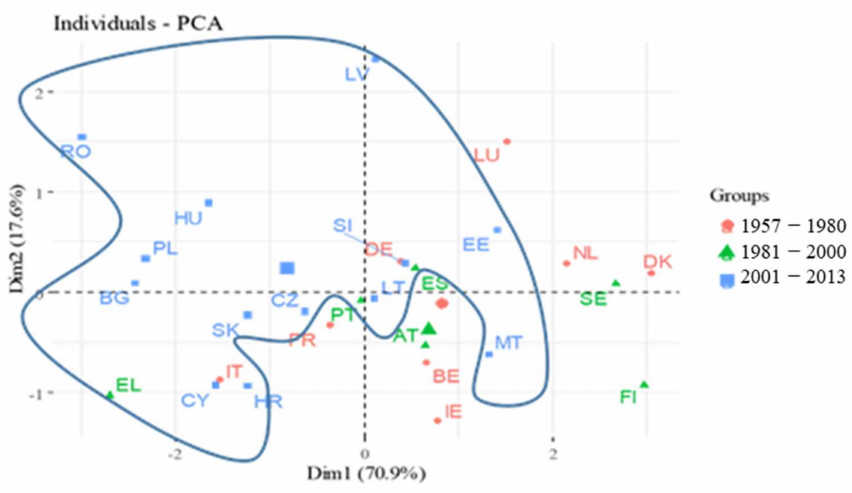
Figure 7. The position of countries on the plane of principal components, grouped by the year of joining the EU (2016).